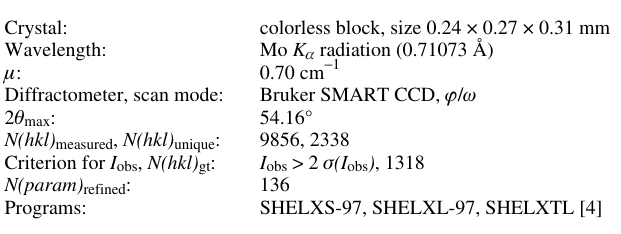
Table 1. Data collection and handling.